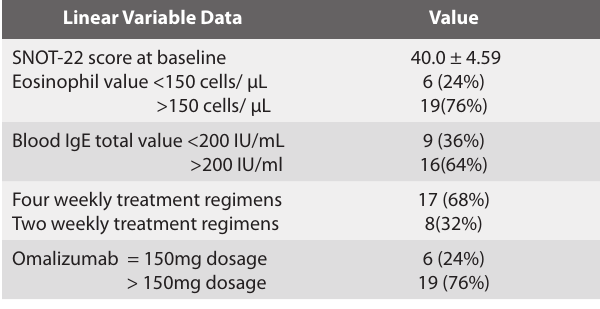
Table 2. Summary of predictor variables included in the linear